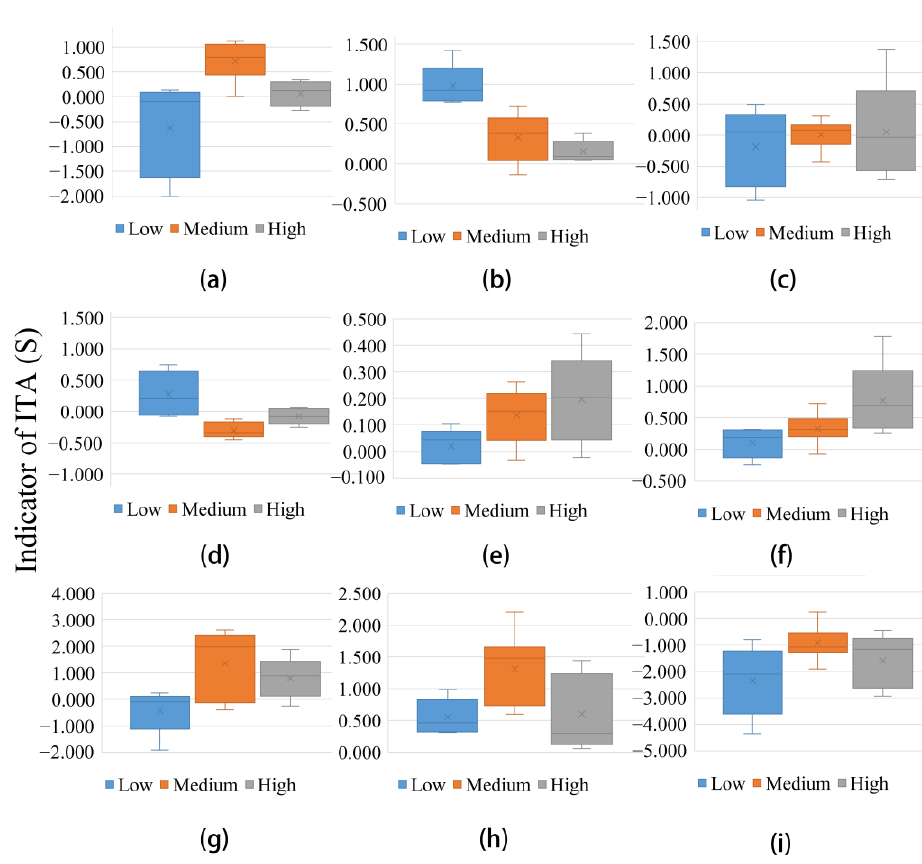
Figure 11. Median value of S (indicator of ITA) for precipitation over the whole JRB: ( a ) annual, ( b ) spring, ( c ) summer, ( d ) autumn, ( e ) winter. Annual precipitation in the sub-basins ( f ) SRJRB, ( g ) UPJRB, ( h ) YLRB and ( i ) MLJRB. Blue, orange, and gray box denote the low, medium, and high categories, respectively.